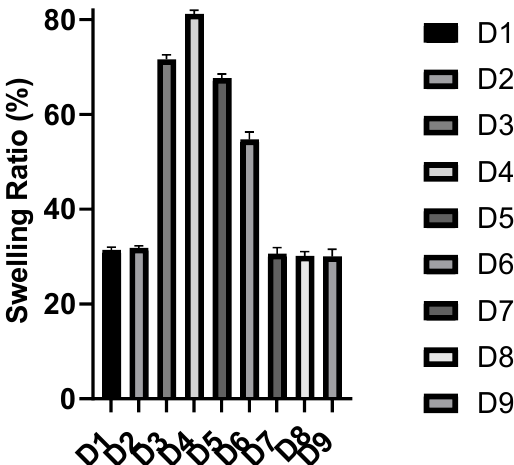
Polymers 2022 , 14 , x FOR PEER REVIEW 10 of 14 Figure 2. The equilibrium swelling ratios of the polymeric formulations (mean ± SD, n = 3) at pH 1.2.